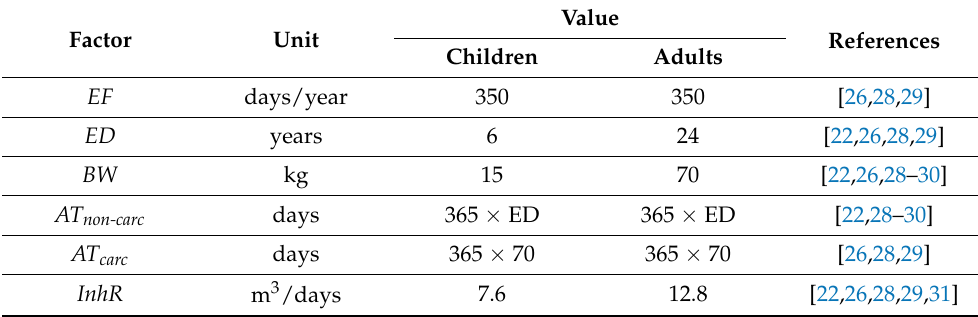
Table 2. Values of exposure factors for elemental doses for children and